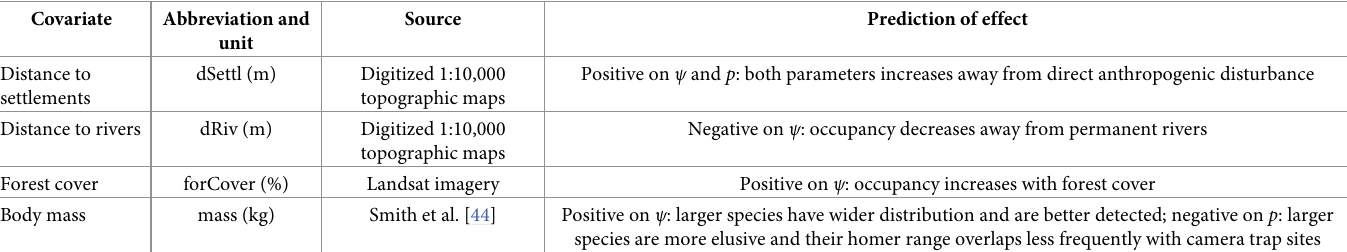
Table 2. Habitat and anthropogenic covariates and species traits. Covariates and traits used to model community occupancy ( ψ ) and detectability ( p ) across the land- scape, with predictions for their effect on these parameters (see text for further details).